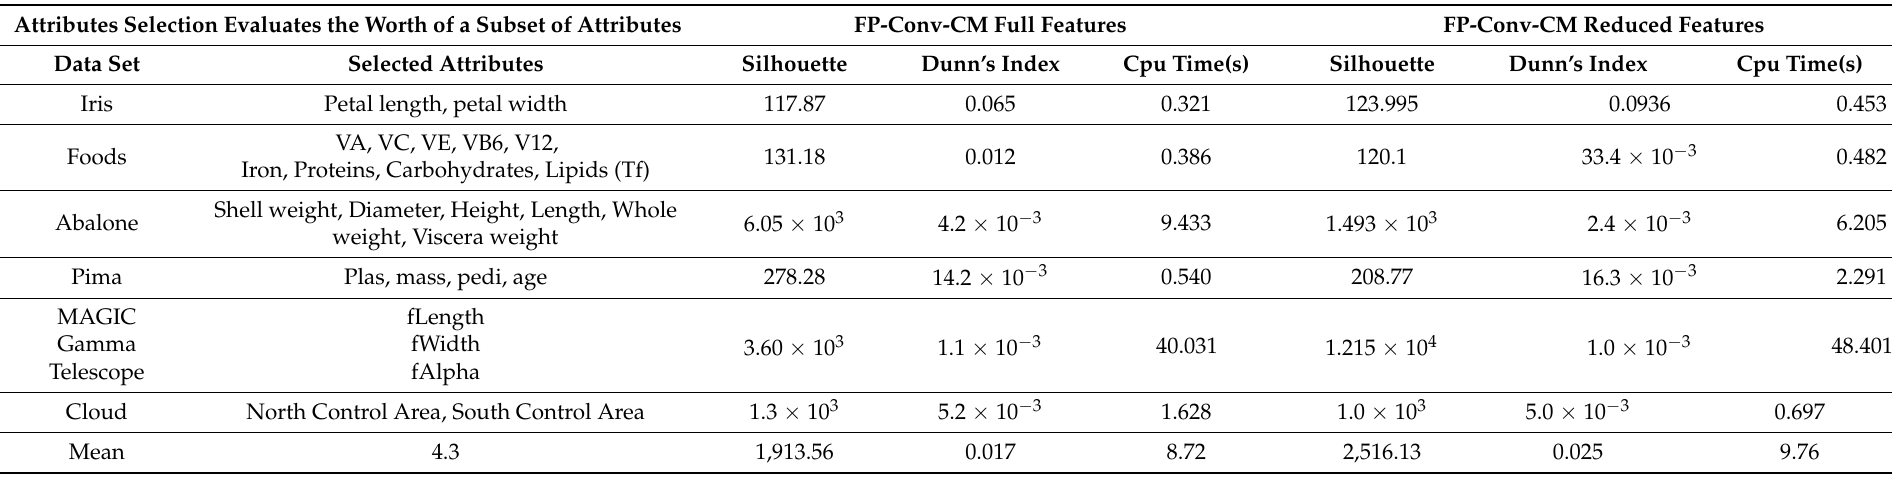
Table 3. Dunn’s index, Silhouette, and CPU time of FP-Conv-CM for different datasets with full and reduced features using the SCE